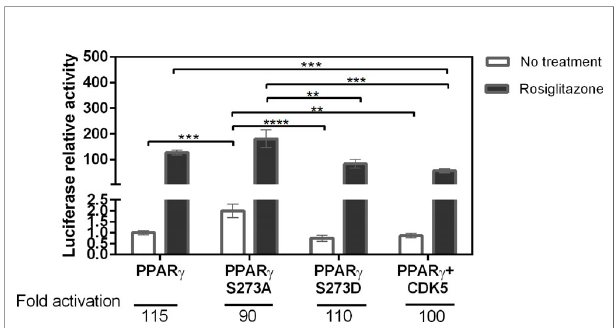
FIGURE 1 | Activation of PPAR g in different phosphorylation states. Transactivation assay with reporter gene in mammalian cells (Hek293T) was used to evaluate the activation pro fi le of PPAR g wt and its mutants in the presence and absence of the Rosiglitazone. The PPAR g S273A mutant prevents the occurrence of phosphorylation, the PPAR g S273D mutant is a structural phosphomimic. The CDK5 enzyme is responsible for the phosphorylation of PPAR g in S273. It is possible to observe that phosphorylation prevention increases activation of PPAR g . Eight assays were performed in biological triplicate with n = 24. Statistical analysis: one-way ANOVA. p ≤ 0.01** p ≤ 0.001***; p ≤ 0.0001****. The phosphorylation inhibitor mutant had greater activation relative to the other